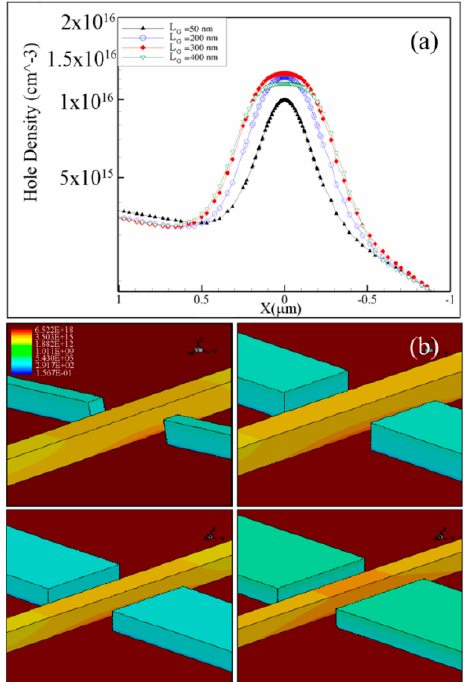
Figure 7. ( a )Hole density distribution along the channel of devices with four L G at a cutline at Z = 50 nm and ( b ) side view of hole density distribution at V G = − 2.0 V and V D = − 1.0 V.